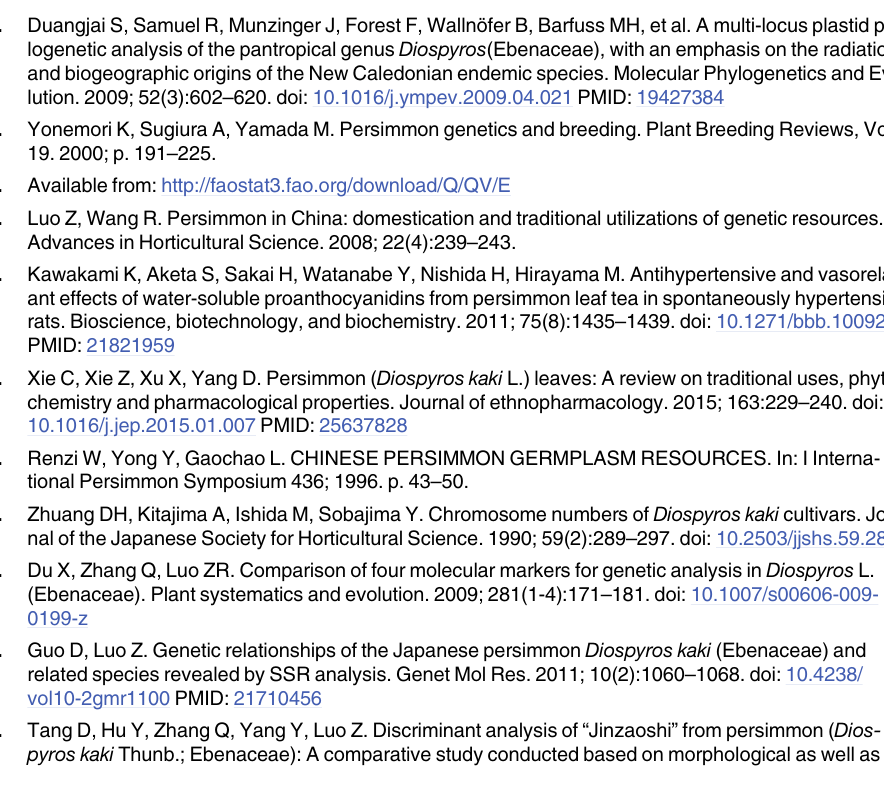
S3 Fig. Phylogenetic trees reconstructed based on 4 hypervariable sequences of Diospyros . (a) Maximum likelihood tree (b) Maximum parsimony tree. (TIF) S4 Fig. Maximum likelihood tree reconstructed based on 61 protein-coding sequences shared by 19 angiosperm species. (TIF) S5 Fig. Phylogenetic tree constructed based on the single sequence repeat sequences. (TIF) S6 Fig. Phylogenetic tree constructed based on the internal transcribed spacer region sequences.